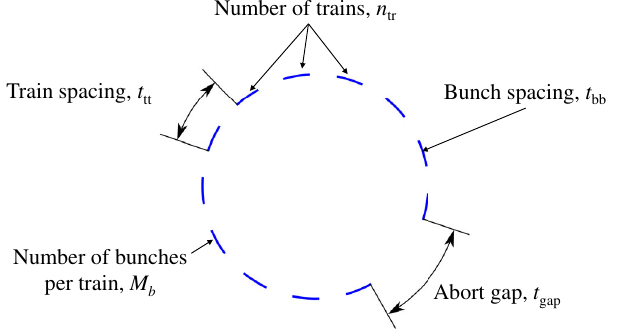
FIG. 1. Sketch of the filling schemes used for the present study.